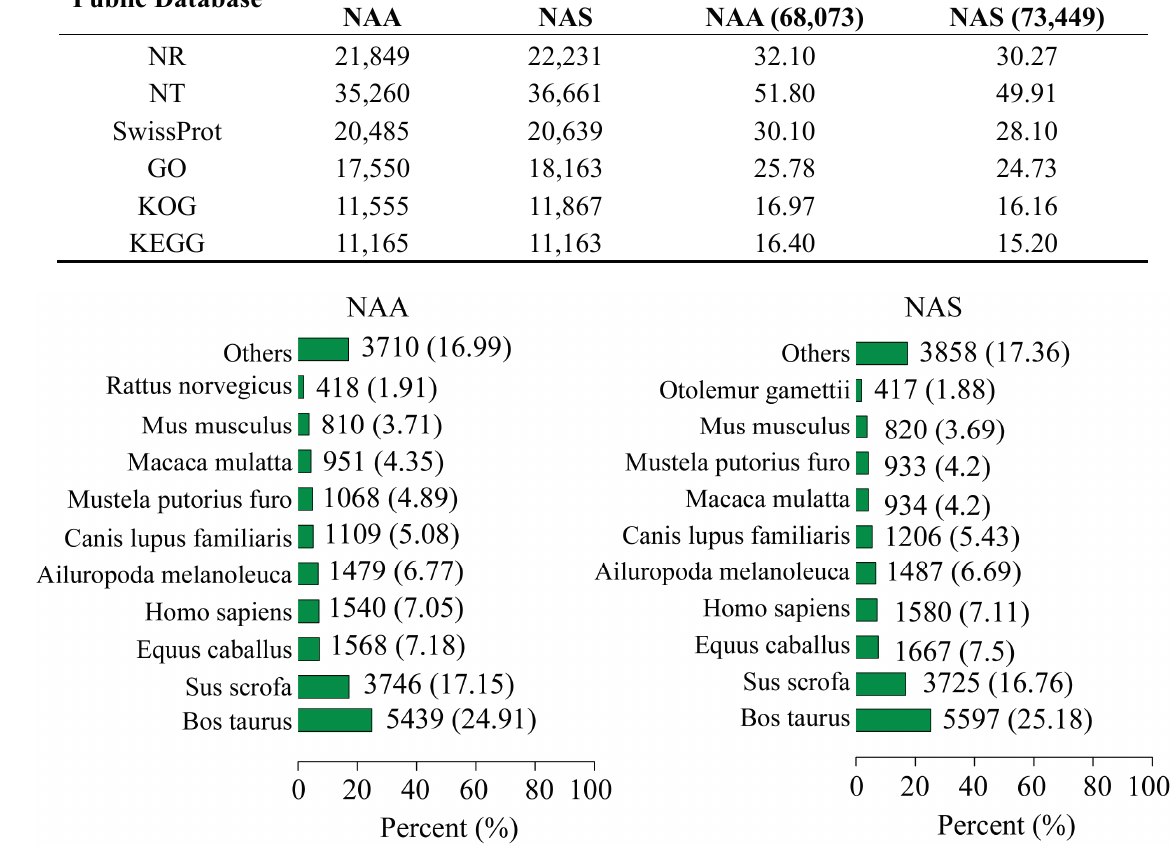
Figure 1. Distributions of the species similarity in NAA and NAS. NAA: the Yangtze finless porpoise; NAS: the East Asian finless